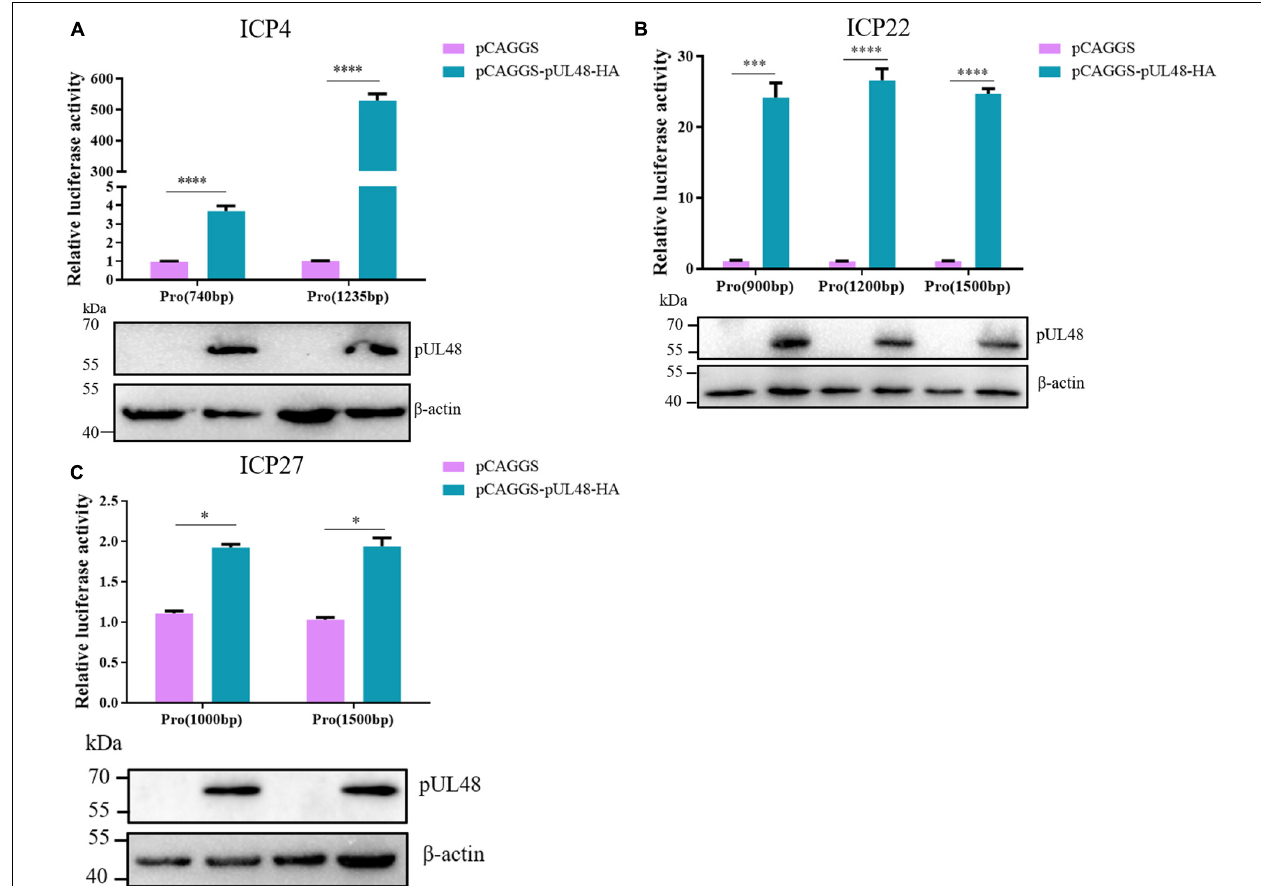
FIGURE 2 | Regulation of pUL48 on promoters of different lengths of intermediate-early (IE) gene. The regulation of pUL48 on ICP4/ICP22/ICP27 promoters of different lengths. ICP4-Pro (740 bp)-Luc, ICP4-Pro (1,235 bp)-Luc, ICP22-Pro (900 bp)-Luc, ICP4-Pro (1,200 bp)-Luc, ICP4-Pro (1,500 bp)-Luc, ICP27-Pro (100 bp)-Luc, and ICP27-Pro (1,500 bp)-Luc were cotransfected into DEF with pCAGGS and pCAGGS-pUL48-HA and pRL-TK, respectively. The transfection ratio of pCAGGS and pCAGGS-pUL48-HA with each double luciferase plasmid was 1:1, and the transfection quantity of pRL-TK was 1/20 of each double luciferase plasmid. Cell samples were collected 24 h after transfection. The activity of each promoter was detected by the dual-luciferase reporting system. pCAGGS-pUL48-HA was transfected into DEF. At 24 h after transfection, cellular protein samples were collected for Western blot analysis. Student’s t -test was used to analyze the differences of the two groups. The significance was as follows: ∗ p < 0.05, ∗∗∗ p < 0.001, ∗∗∗∗ p <